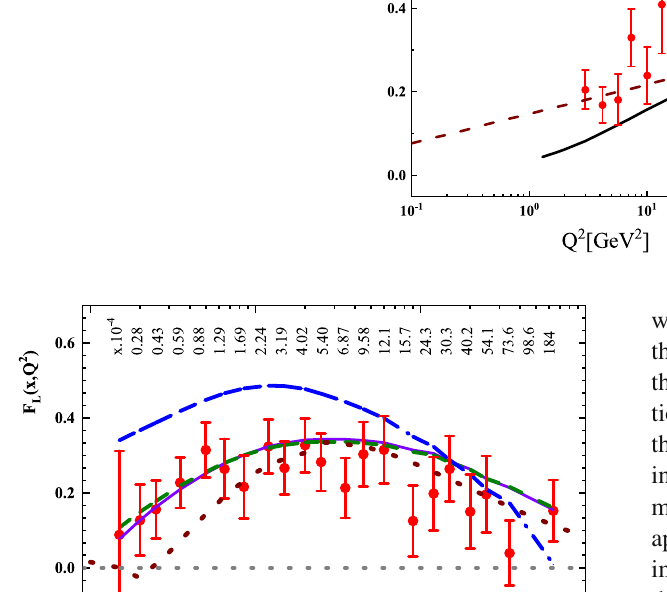
Fig. 4 The derivative (∂ F /∂ ln Q 2 ) x plotted as a 2 function of Q 2 for fixed x compared with the H1 Collaboration data [65] as accompanied with total errors. The linear and nonlinear behaviors are obtained from the parametrization model